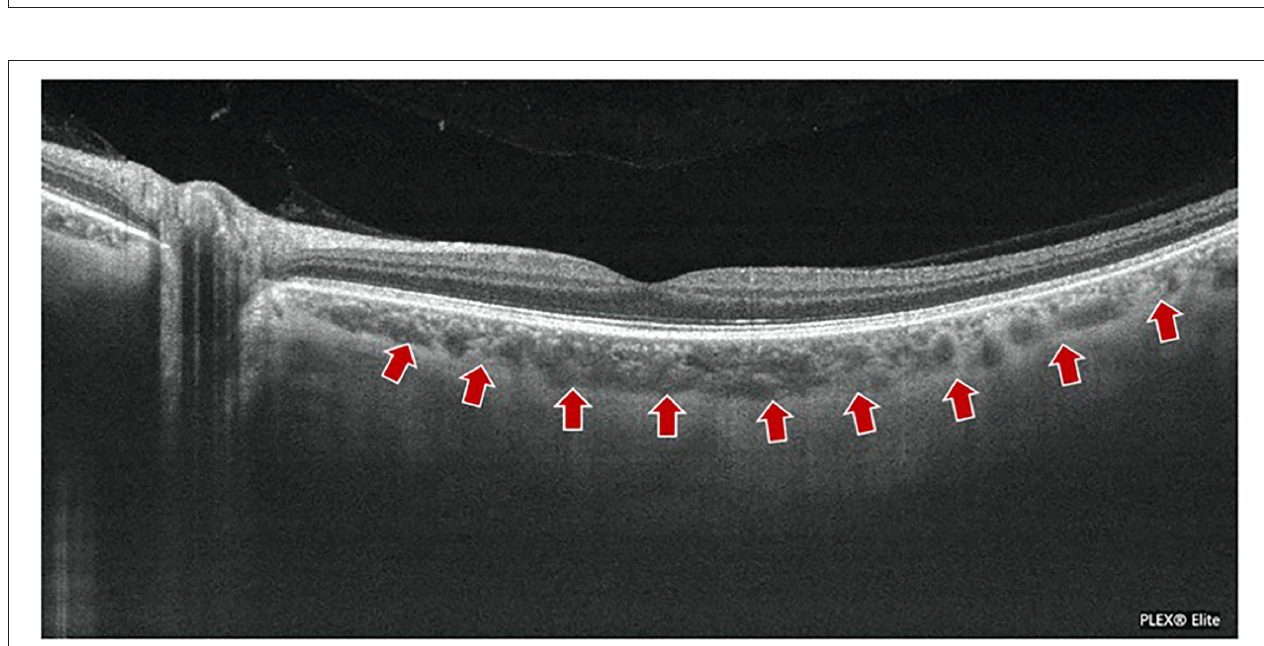
FIGURE 2 | A representative EDI-OCT B-scan imaging of a 57 years old subject. The choroid boundary is detected vaguely. An EDI-OCT (Optovue, Inc., California, United States) B-scan image shows the choroid–sclera boundary (arrows) with a central wavelength of 850nm, which made the zero-delay line to the choroid by moving the device closer to the eye, thus improving image resolution and facilitating the identification of the choroid–scleral interface. EDI OCT, enhanced depth imaging OCT; SD-OCT, spectral domain OCT.